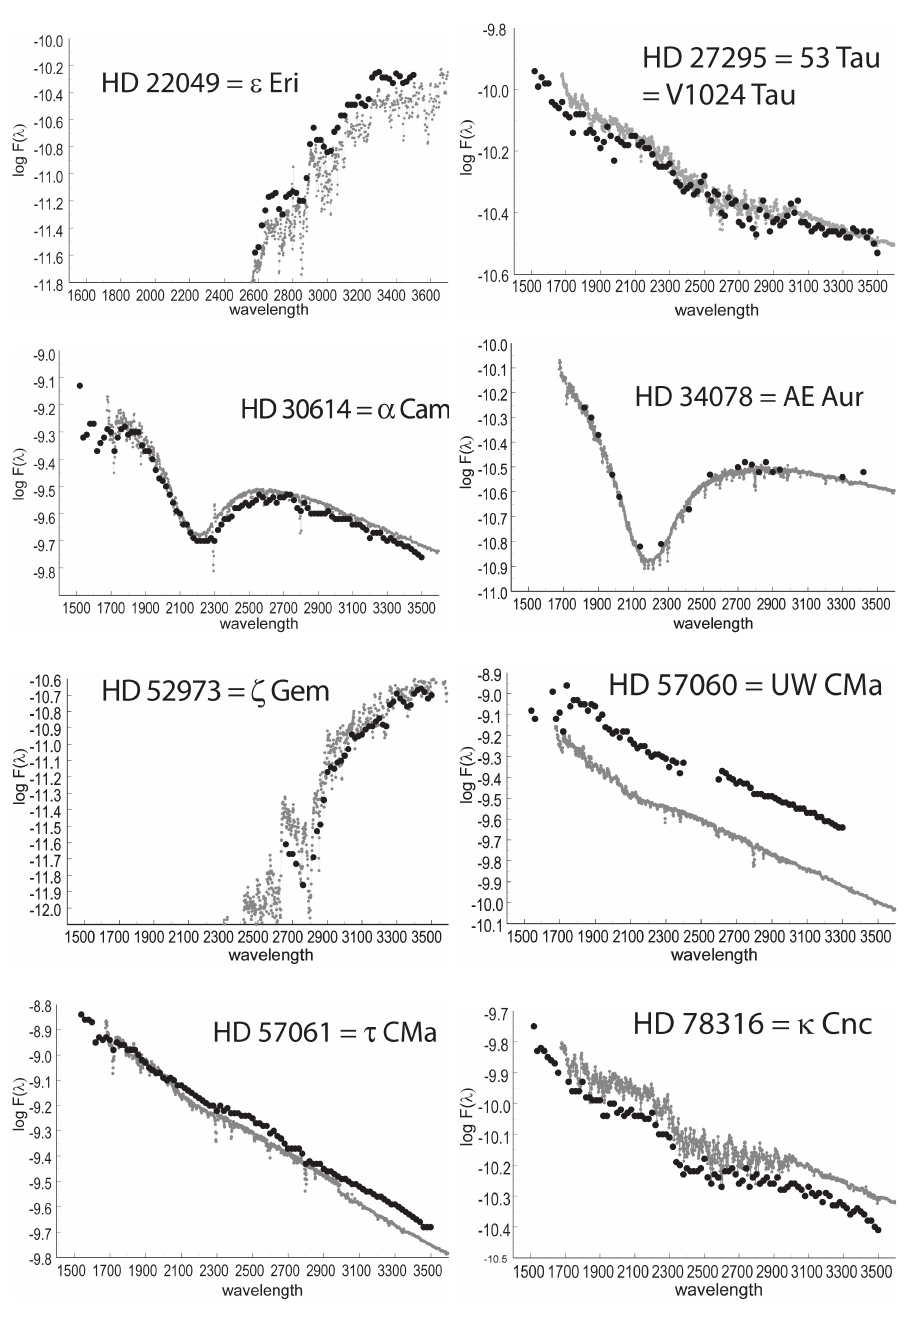
Fig. 1. Comparison between the NGSL and Astron data. Grey color: NGSL; black solid circles: Astron. (Continued in Fig.